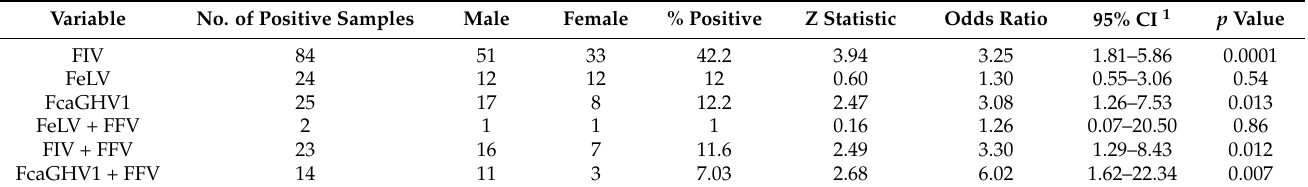
Table 5. Evaluation of the association between sex and another feline virus detection in domestic cats.